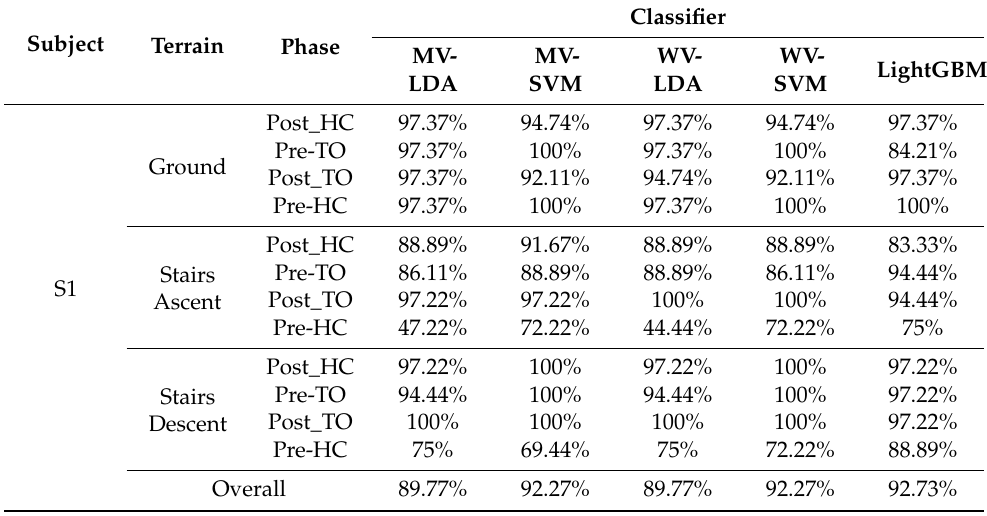
Figure 15. Classification performance for the ensemble learning method; Subject #4. Table 4. Detailed classification performance for the five ensemble learning methods; Subject #1.